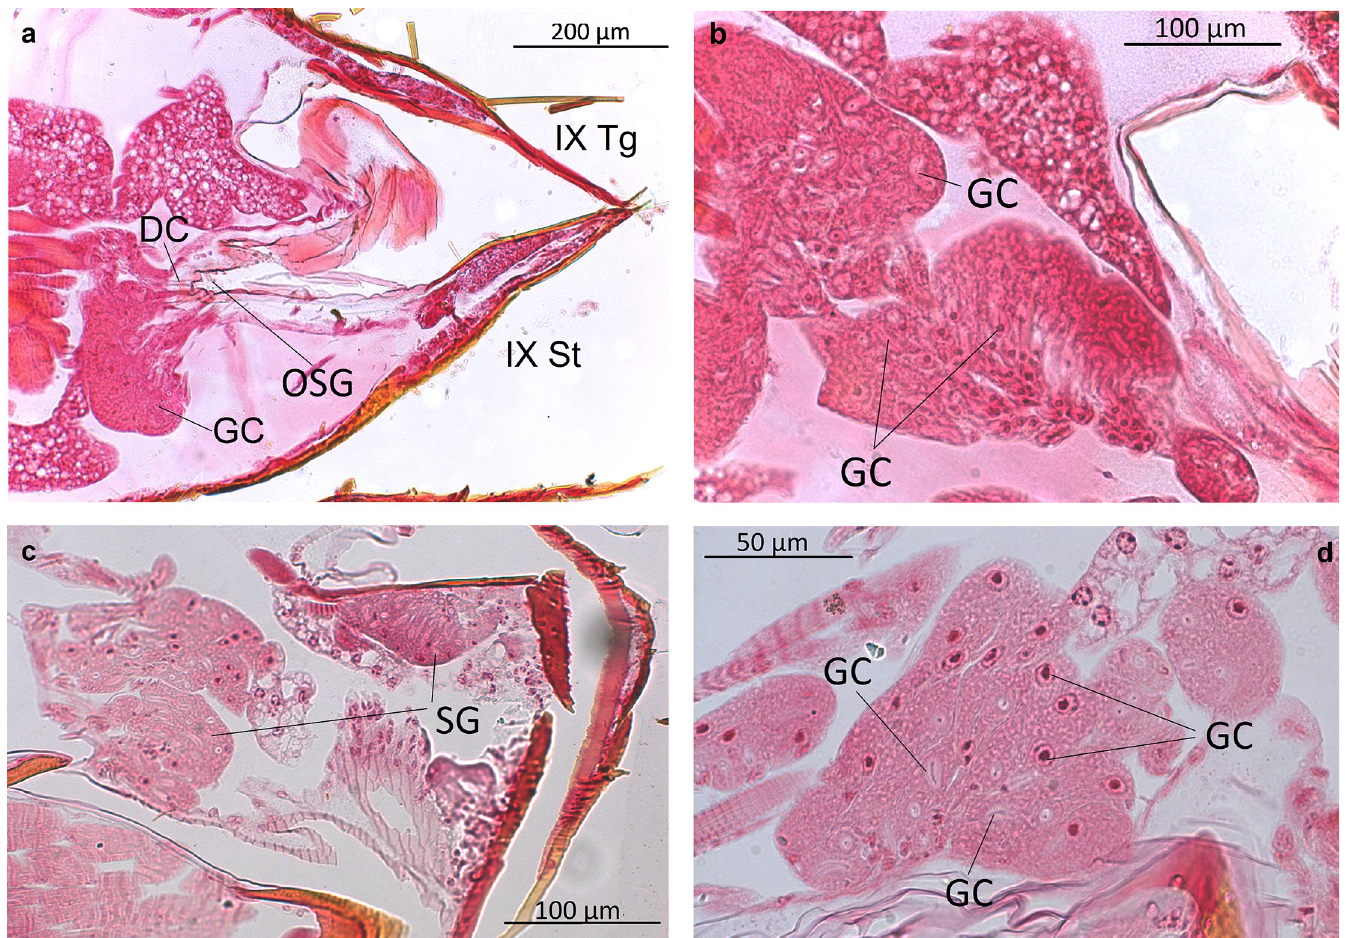
Fig 7. Longitudinal sections through the 9 th abdominal segment of Dinarda dentata . a) Tip of the 9 th segment showing the sternal gland of a Dinarda female. Tg, tergite; St, sternite; OSG, opening of the sternal gland; GC, glandular cell; DC, duct cell. b) Magnification of the sternal gland in Dinarda female. GC, glandular cell; DC, duct cell. c) Sternal land of a Dinarda male. SG, sternal gland. d) Magnification of the sternal gland in a Dinarda male. GC, glandular cells.